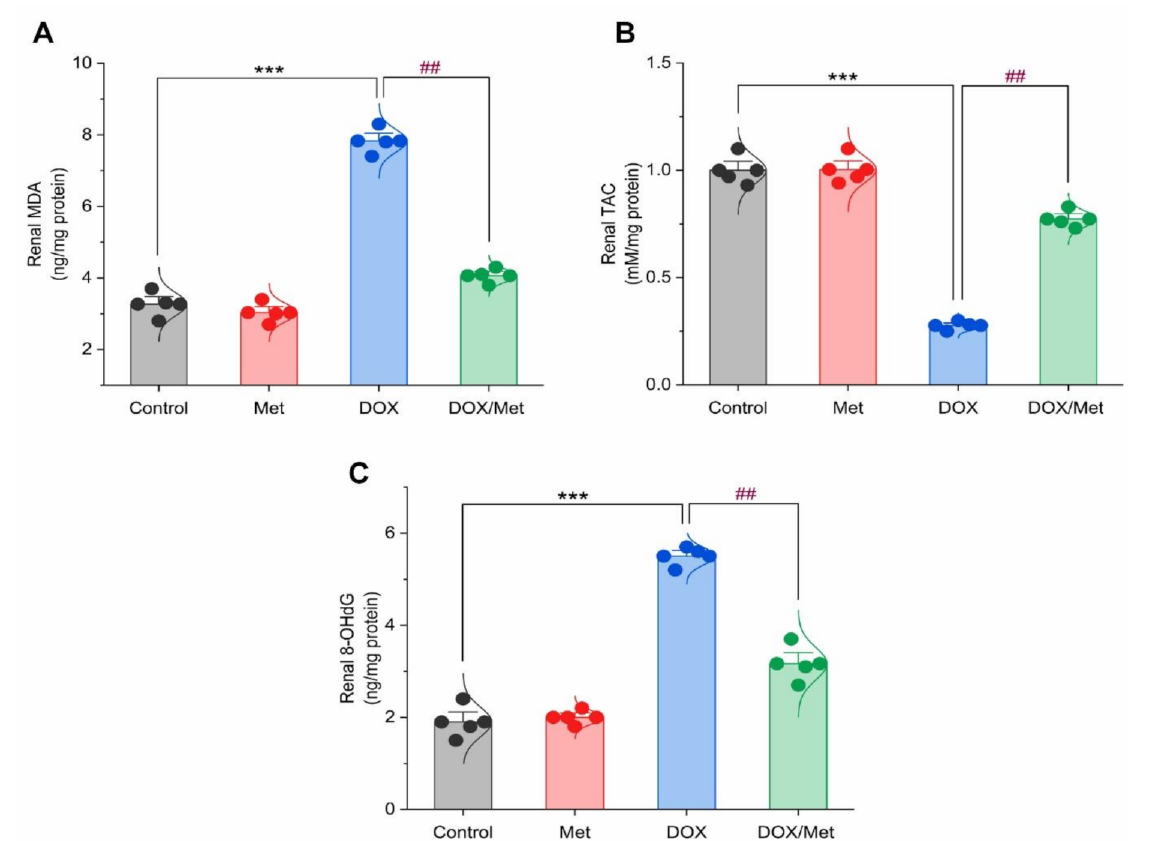
Figure 5. Bar-dot plot of the prophylactic effect of Met on DOX-induced oxidative stress in renal tissue. Prophylactic treatment with Met for 3 weeks decreased renal MDA ( A ) along with increased renal TAC ( B ) and renal 8-OHdG ( C ) content in DOX-induced nephrotoxic mice. Student’s t -test was used for statistical comparisons. Data are expressed as mean ± SEM. Colored dots indicate each individual value and colored curves represent the distribution of each data point. *** p < 0.001 vs. control group and ## p < 0.01 vs. DOX